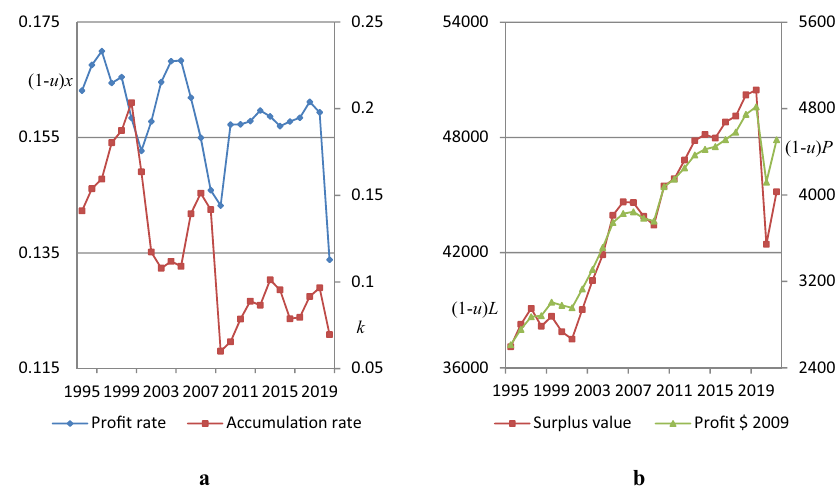
Fig. 17 Rate of capital accumulation, surplus value and profitability in the US economy; a rate of capital accumulation k and profit rate (1